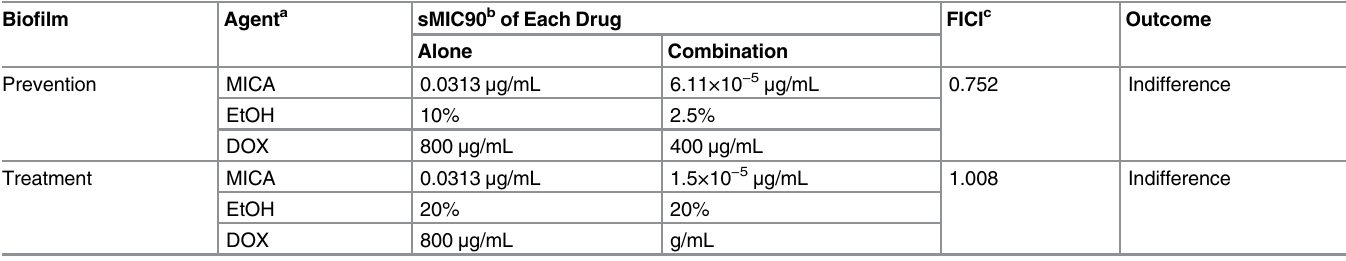
Table 4. Antifungal activity of three-drug combinations against forming and mature C . albicans biofilms, sMIC90. Bio fi